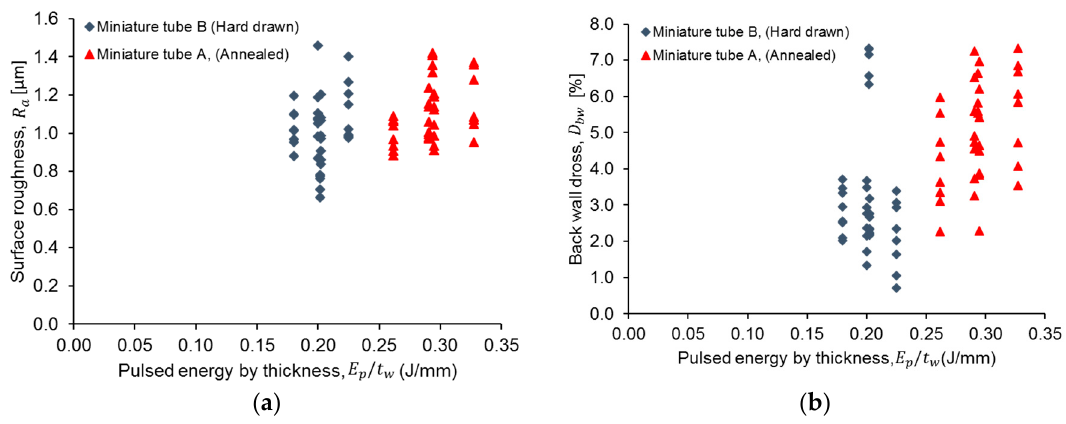
Figure 7. Influence of pulse energy by thickness on ( a ) Surface roughness and ( b ) back wall dross for miniature tube A and B.